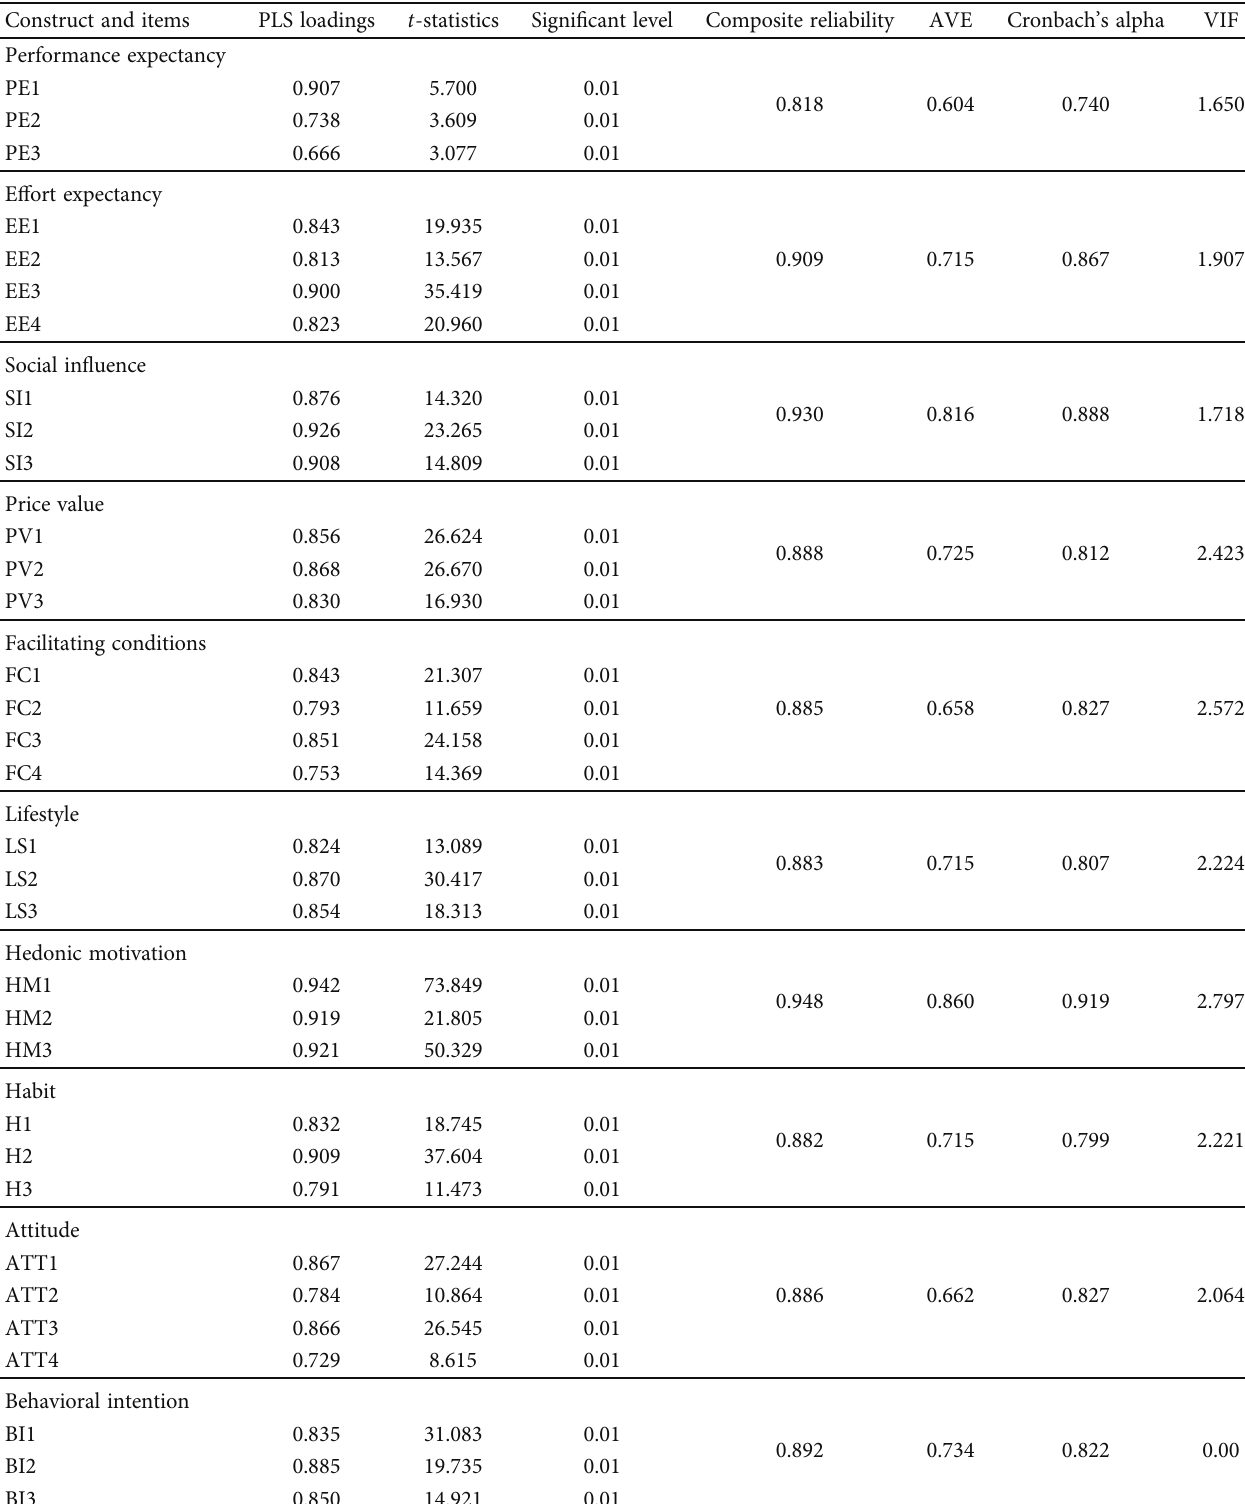
Table 6: Statistical outcomes of the measurement model descriptive result of social media